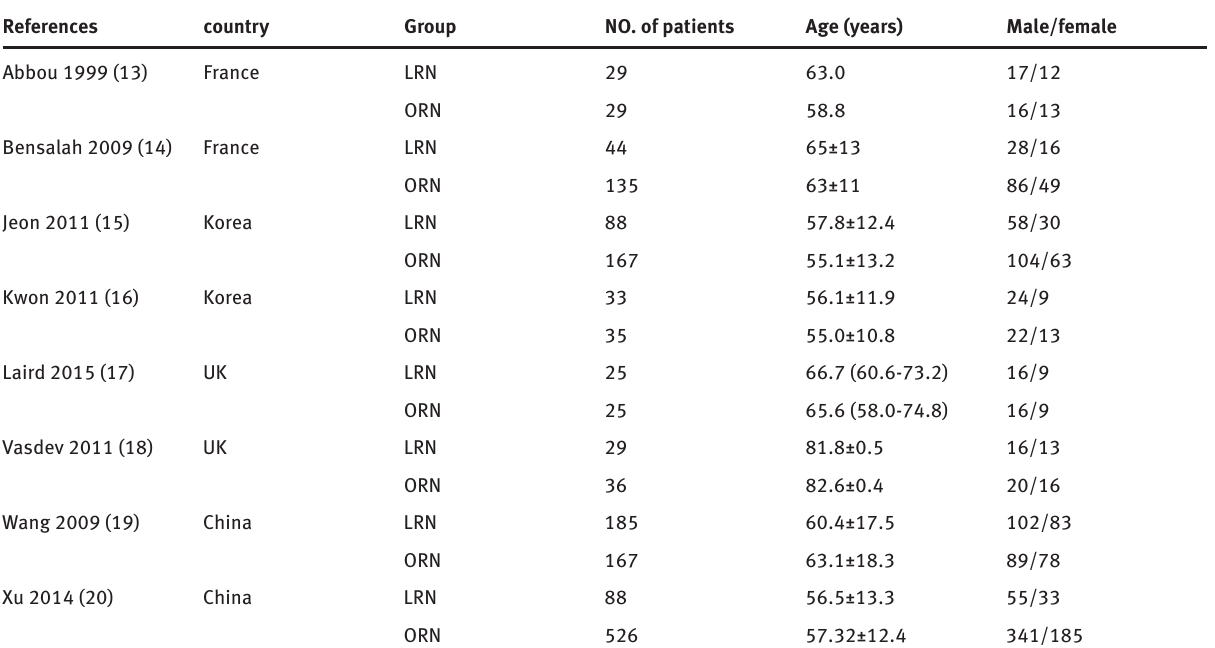
Table 1: Baseline characeristics of included